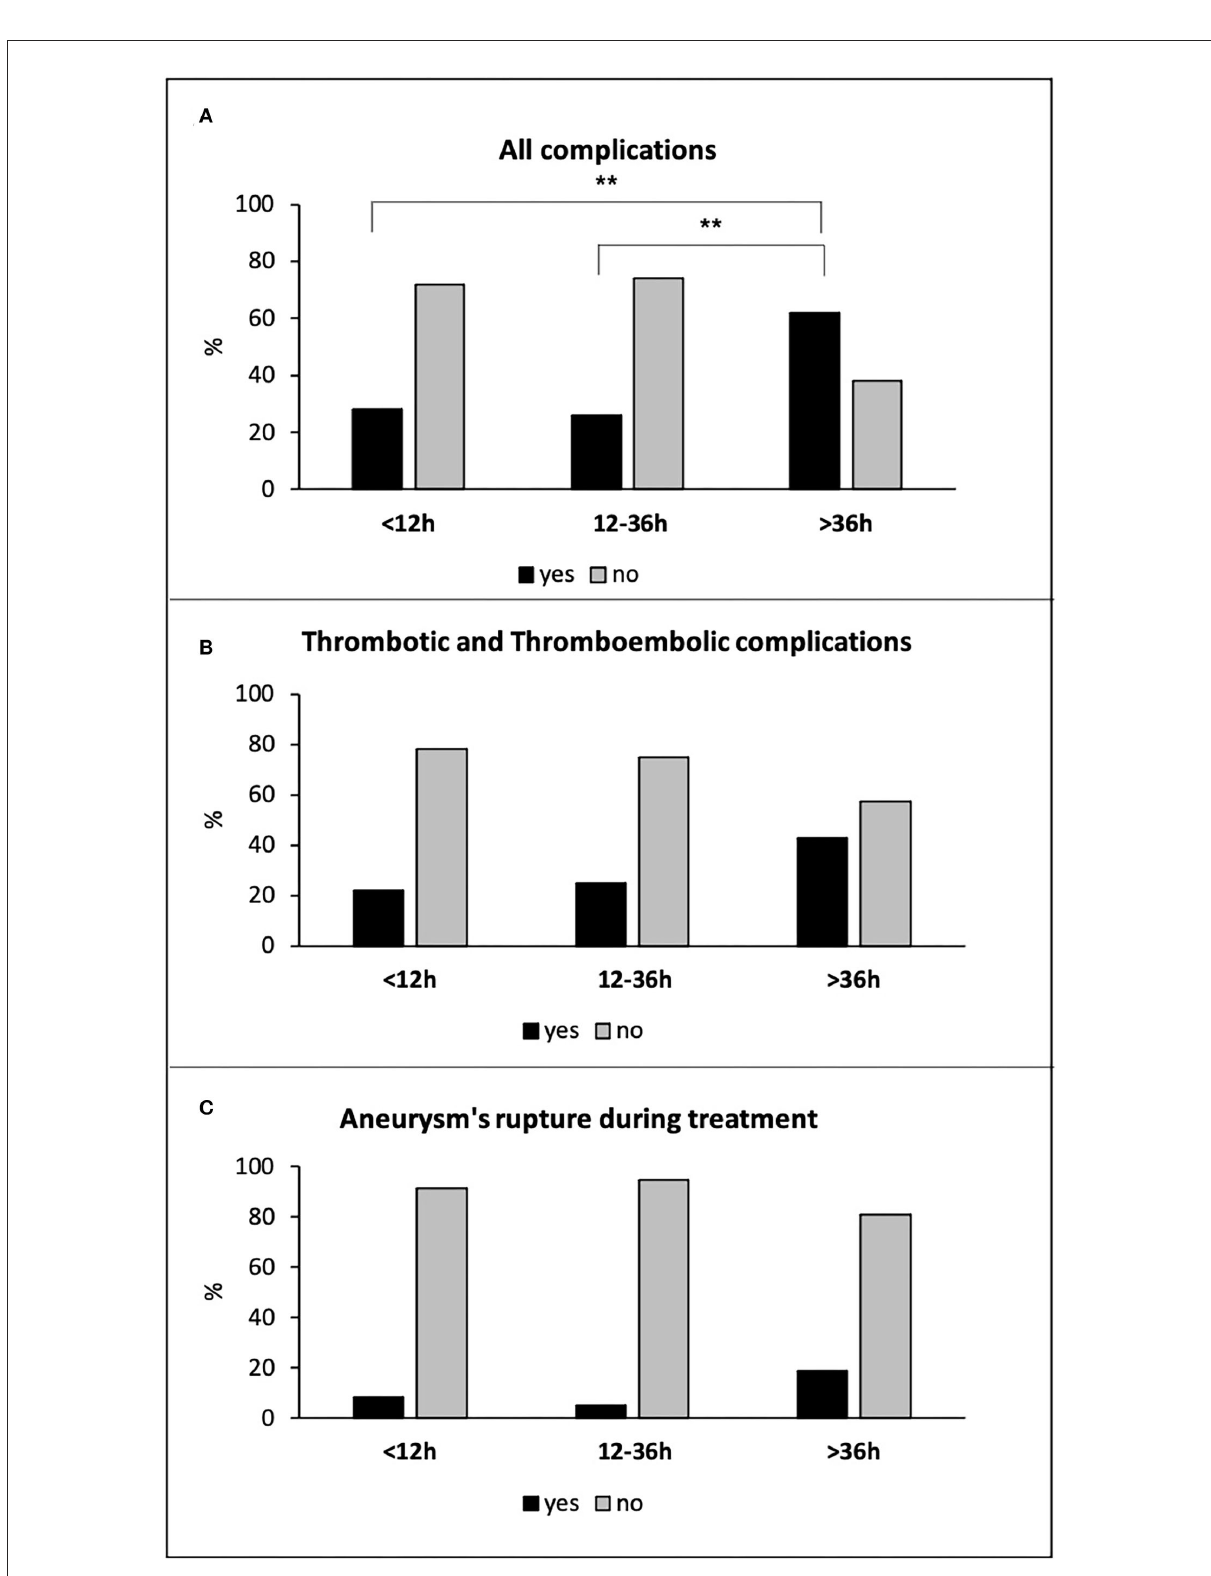
FIGURE3 All complications (A) , thrombotic and thromboembolic complications (B) , and aneurysm’s rupture during treatment (C) in hyper-early, early, and delayed treated patients with simple coiling and balloon-assisted coiling. ** p ≤